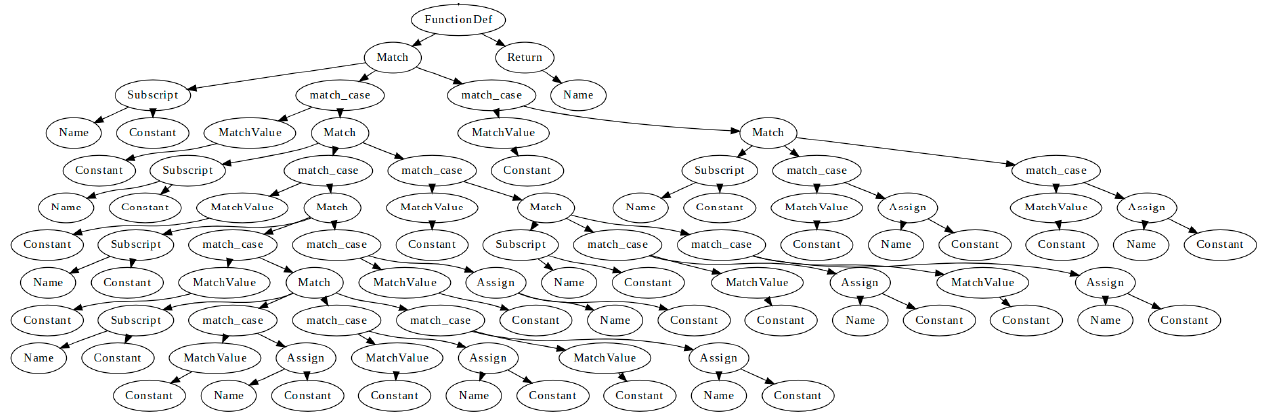
Figure 2. AST of a program that solves one of the automatically generated tasks of type 6 (see Table 1, see Figure 1a) using a pattern matching-based approach, after applying AST transformations during program text vectorization in DTA.